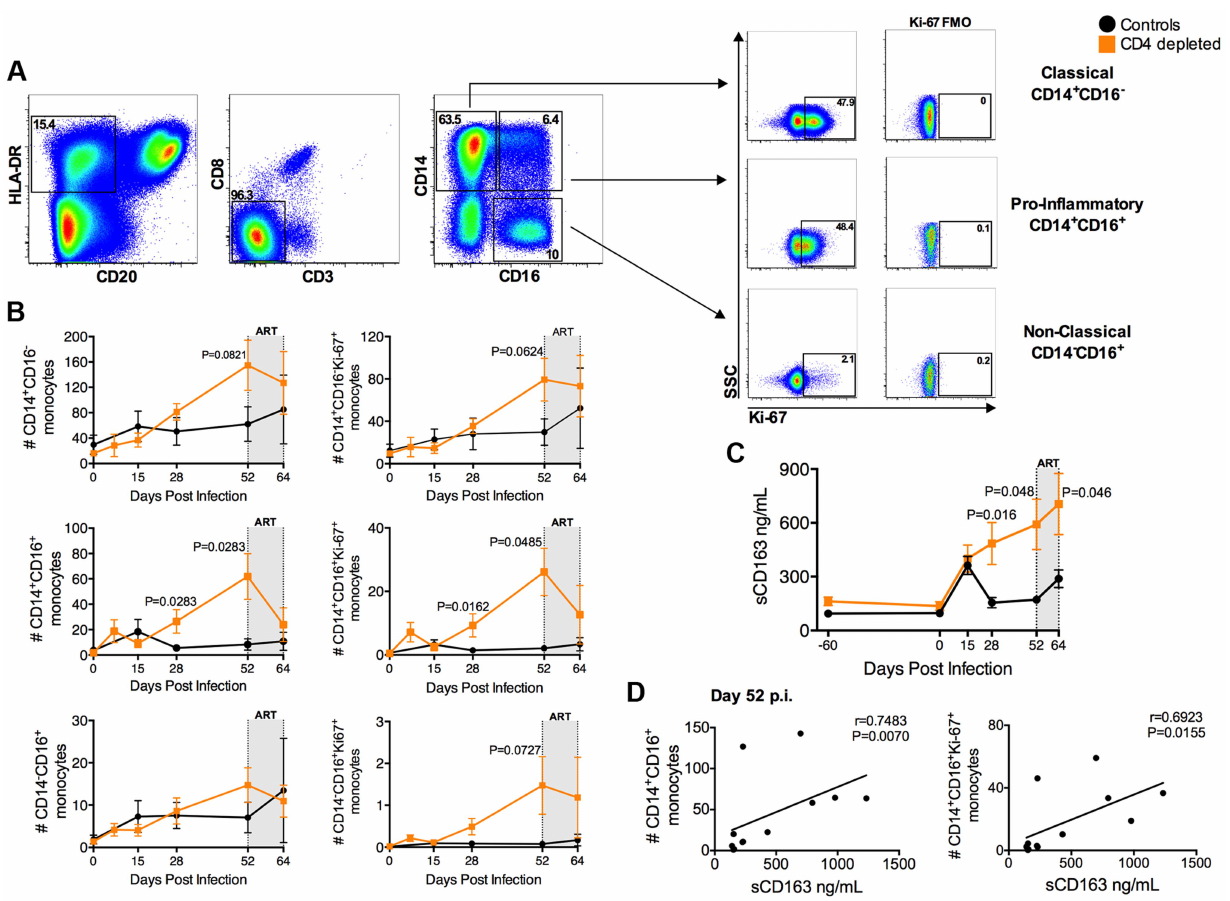
Figure 3. Expansion of activated, pro-inflammatory monocytes in CD4-depleted SIV-infected RMs. ( a ) Representative flow plots of different monocyte subsets as defined by CD14 and CD16 expression. Levels of Ki-67 and FMO controls are represented for classical (CD14 + CD16 2 ), pro- inflammatory (CD14 + CD16 + ), and non-classical (CD14 2 CD16 + ) monocytes. ( b ) Quantification of total and Ki-67 + blood monocyte subsets (cells/ m l) in SIV- infected CD4-depleted (orange square; n=8) and undepleted control (closed circle; n=4) RMs. In depleted RMs, the number of total and proliferating CD14 + CD16 + monocytes was significantly higher than undepleted controls at day 28 and 52 post-infection. ( c ) In CD4-depleted RMs (orange square; n=8) plasma levels of soluble CD163 (sCD163) were significantly higher than undepleted controls (closed circle; n=4) at day 28 and day 52 post-infection, as well as after 12 days of ART. ( d ) Plasma level of sCD163 significantly correlates with the numbers of CD14 + CD16 + and of CD14 + CD16 + Ki-67 + monocytes in all SIV-infected RMs (day 52 p.i.; n=12; Spearman rank correlation tests). The gray box in the graphs of panels b and c indicates the 12 days of